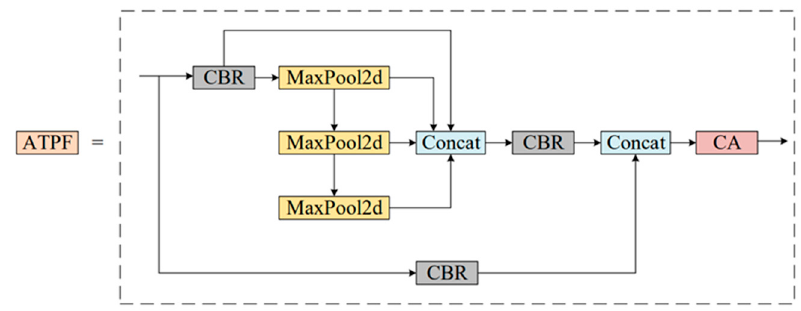
Figure 4. Structure diagram of the ATPF module.